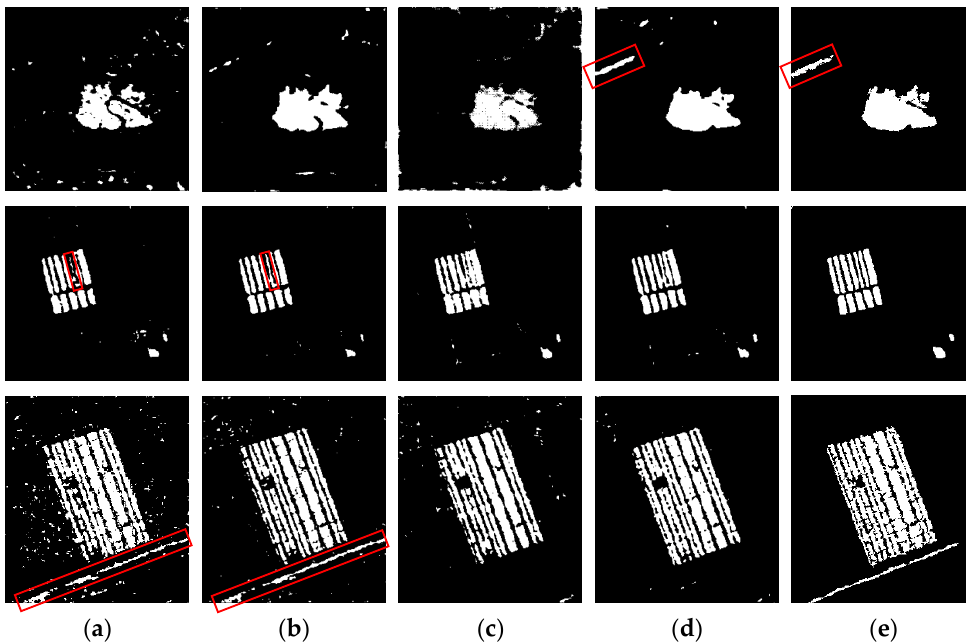
Figure 13. Change detection results of transfer learning experiment for SAR datasets, including the San Francisco (first row), Farmland-A (second row) and Farmland-B datasets. ( a ) FC-Siam-diff; ( b ) SSN-Siam-diff; ( c ) FC-Siam-conc; ( d ) SSN-Siam-conc; and ( e ) ground truth. The areas marked by red boxes deserve more attention. Table 5. Quantitative results of transfer learning experiment for San Francisco dataset. Table 7. Quantitative results of transfer learning experiment for Yellow River–Farmland-B